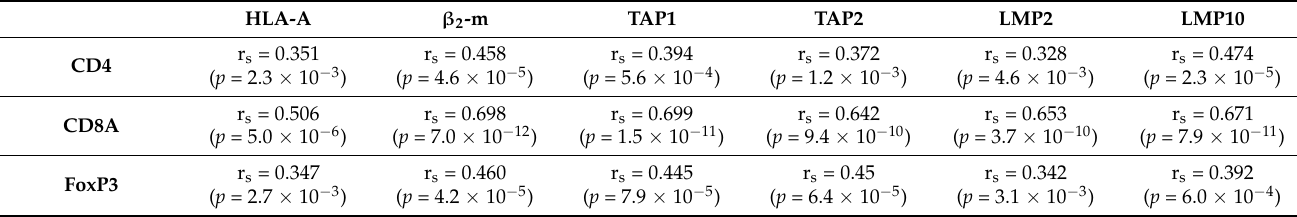
Table 6. Correlation of the mRNA Expression of HLA-I/APM Components with T Cell Markers Using TCGA Data from HPV − HNC